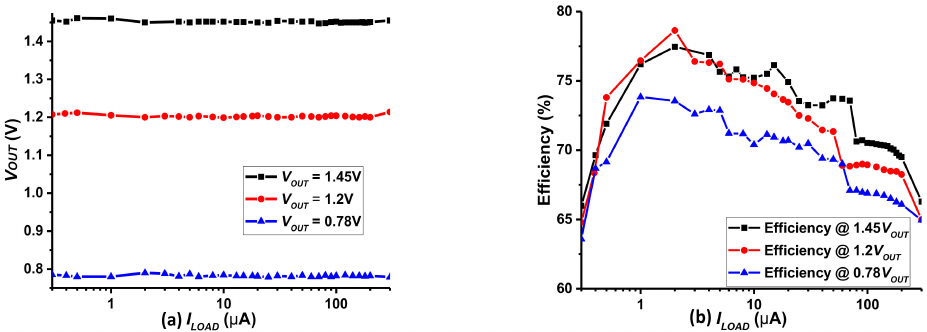
Figure 21. ( a ) Regulated output voltage vs. I LOAD . ( b ) Corresponding efficiencies.